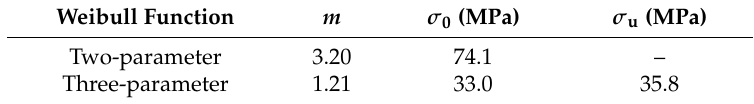
Table 1. Parameters for two- and three-parameter Weibull Distribution Function (4).